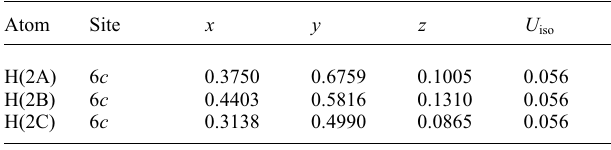
Table 3. Atomic coordinates and displacement parameters (in Å 2 )